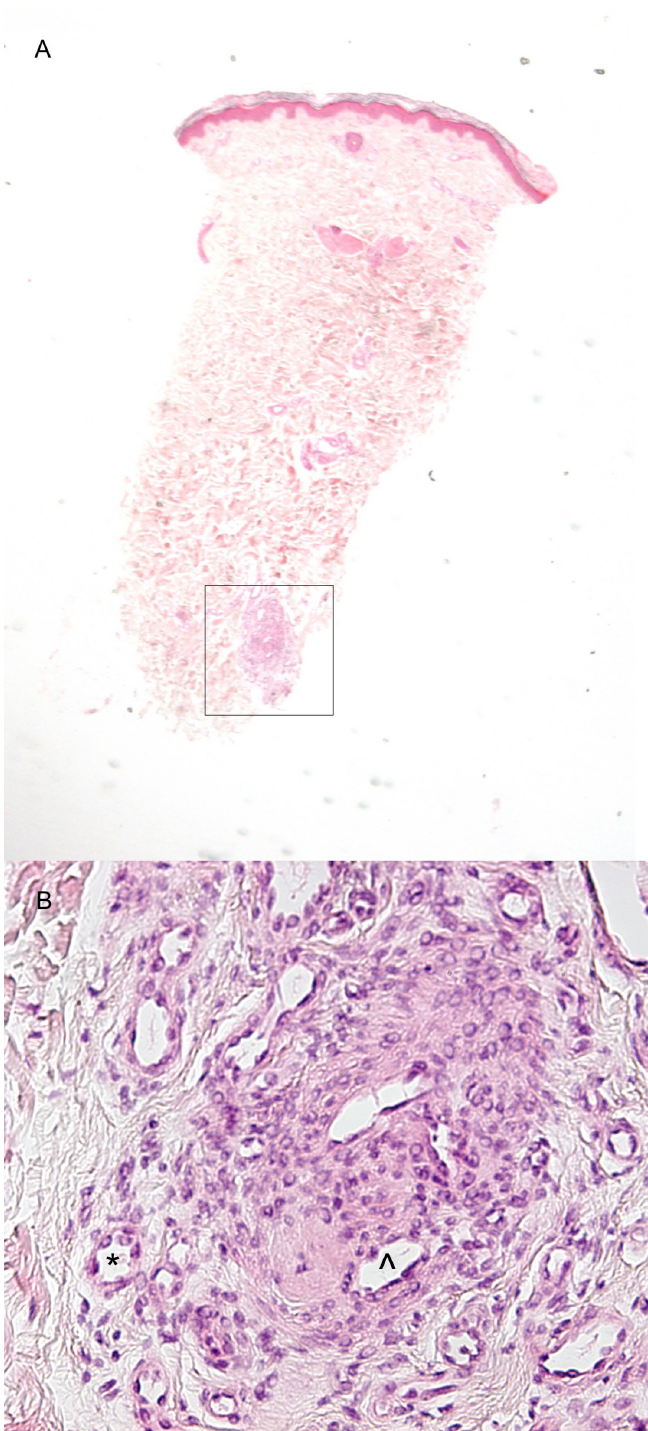
Fig 3. Example two of a probable occlusive microangiopathy. (A) Low magnification shows that the abnormal arteries are located in the deep dermis (box) (H&E, 20x). (B) In detail, extensive neovascularization ( � ) and recanalization (^) are visible (H&E,